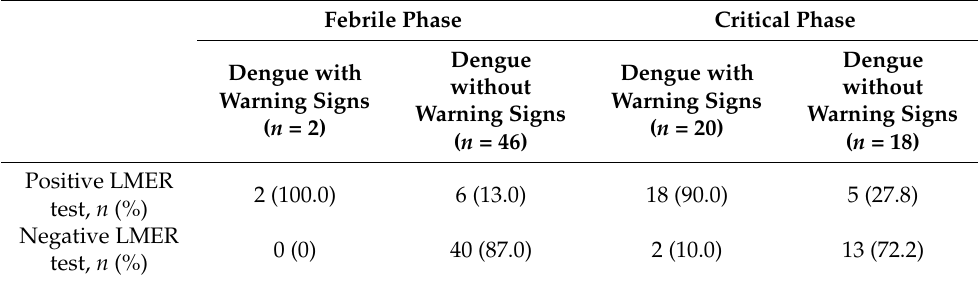
Table 2. The outcomes of the intestinal permeability test by using the lactulose-to-mannitol excretion ratio (LMER) stratified by warning signs and phases of dengue infection at the time of enrollment ( t = 0). Febrile